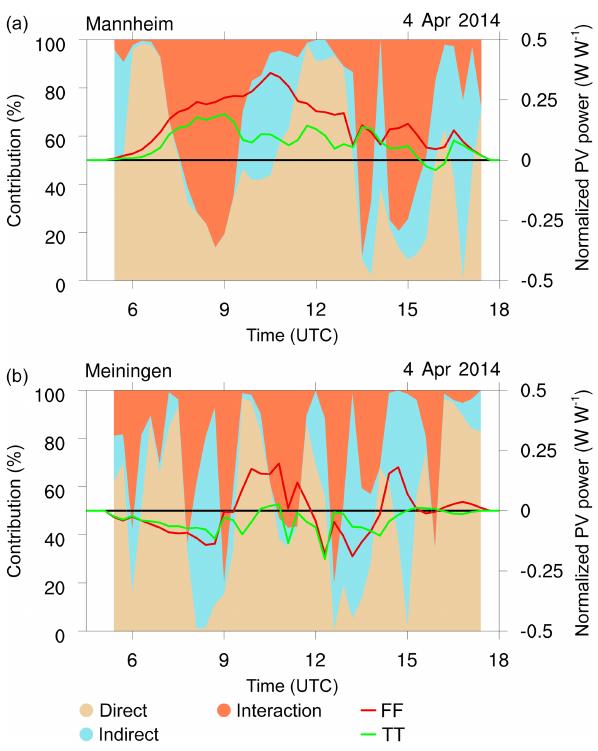
Figure 13. Same as Fig. 12 for Trier (a) and Weihenstephan (b)